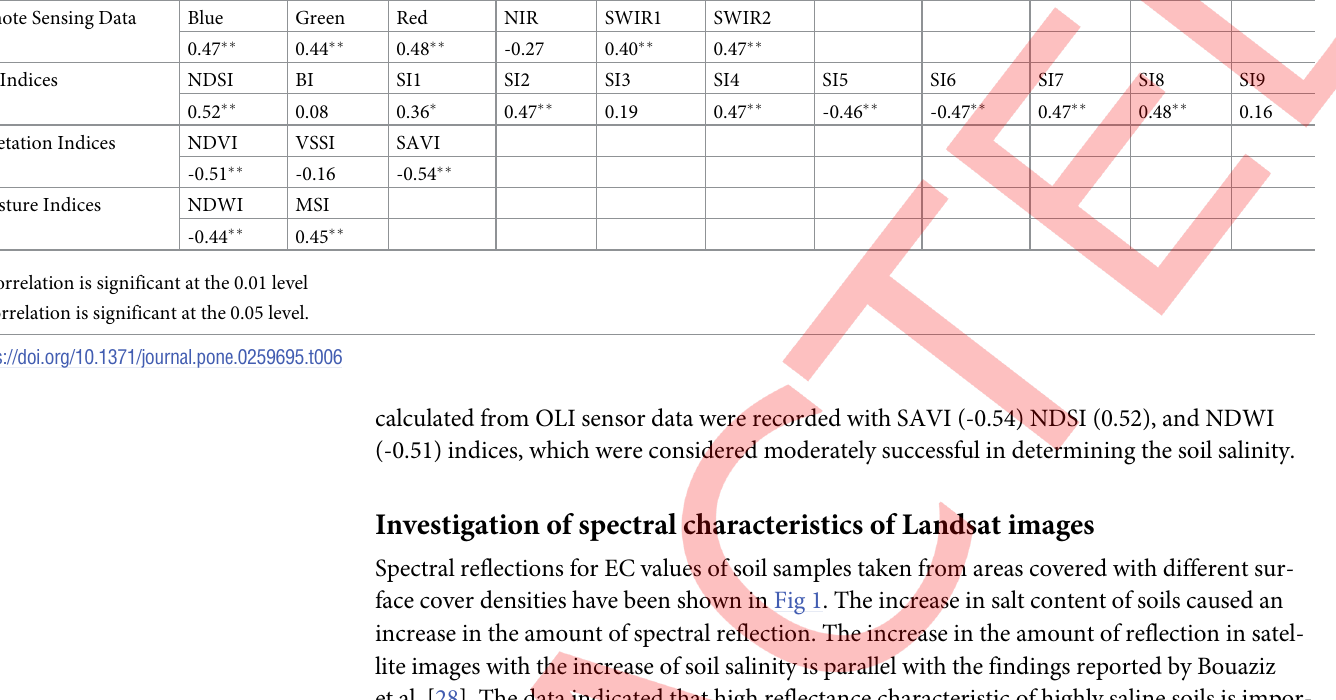
Table 6. The correlations between wavelengths and indexes calculated from OLI sensor and logEC values. Remote Sensing